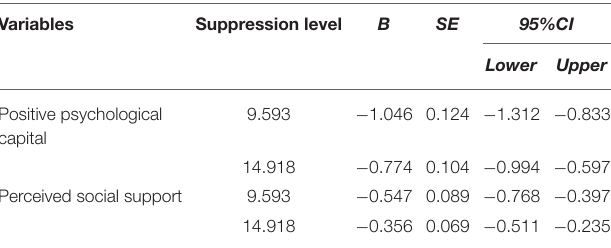
TABLE 4 | Mediating effect values of positive psychological capital and perceived social support on different levels of suppression.